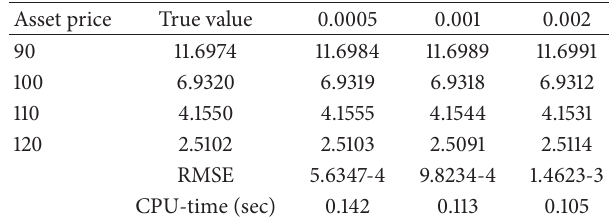
Table 2: Convergence in time for fixed space step ℎ = 0.01 for the problem with parameters (56).